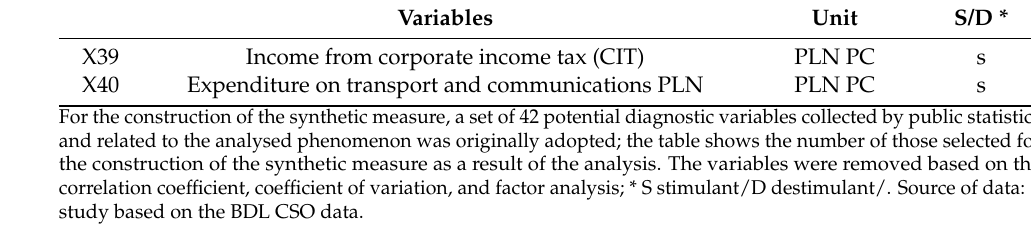
Table 1. Cont. Variables Unit X39 Expenditure on transport and communications